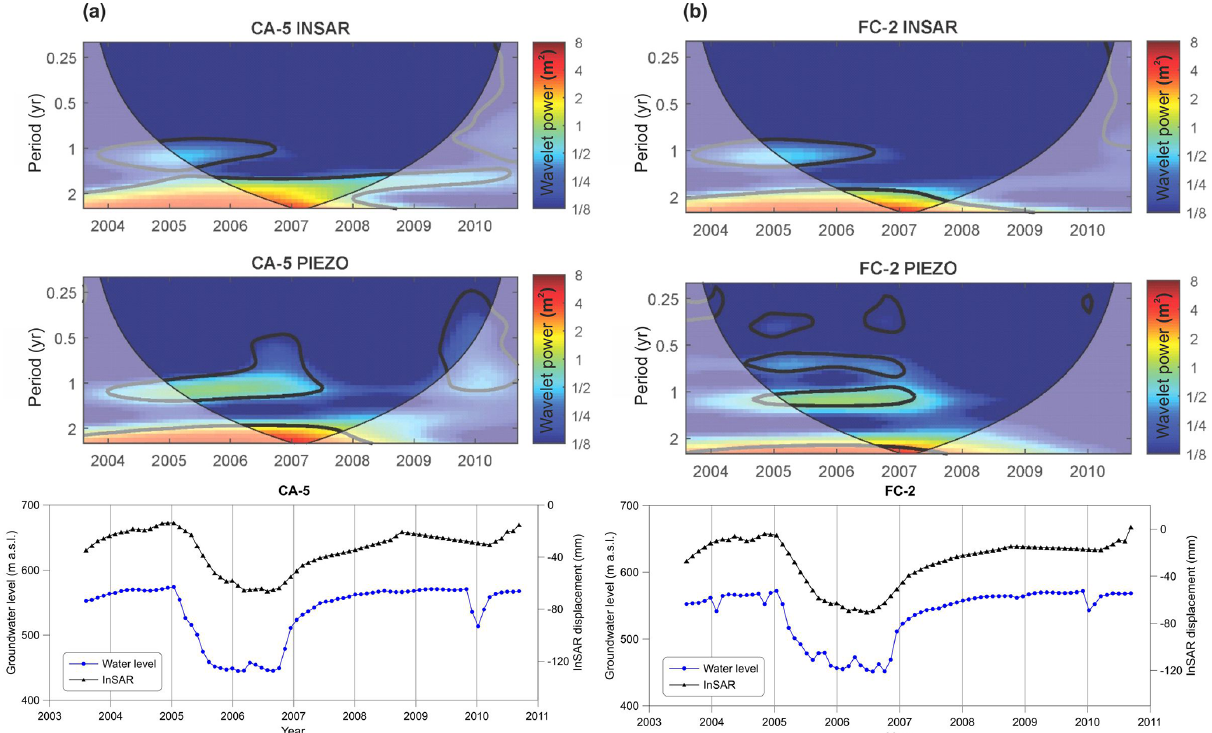
Figure 3. CWT power spectra of InSAR displacements and piezometric data shown with water-level time series for two wells (a) FC-2 and (b) CA-5 in the TDAM. Colour scale is described in Fig. 1